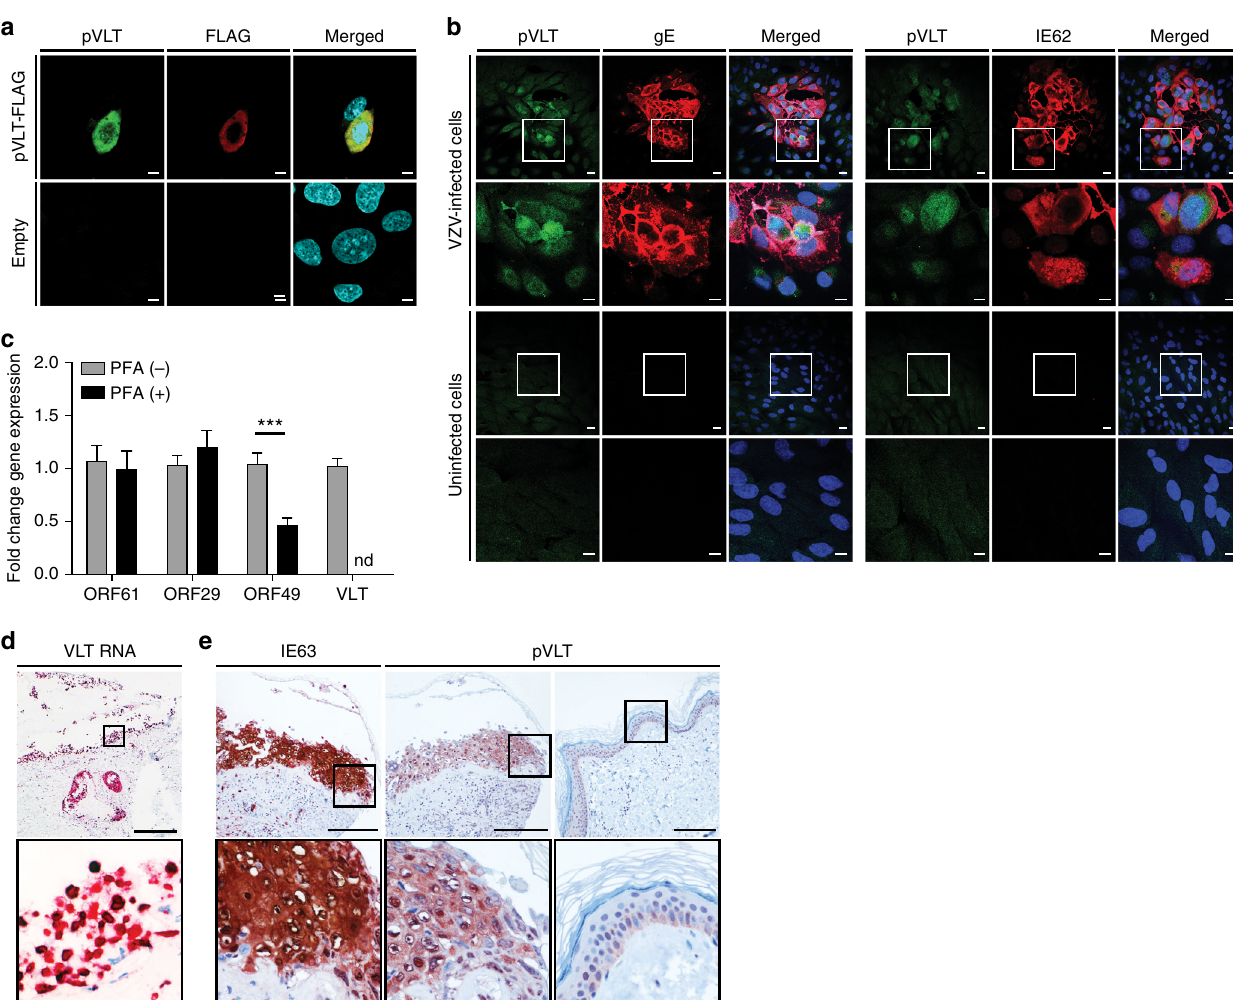
Fig. 5 Expression of VLT protein in vitro and in situ. a Representative confocal microscopic image of ARPE-19 cells at 48 h post-transfection with C-terminal FLAG-tagged VLT (pVLT-FLAG) expression plasmid or empty control plasmid (empty). pVLT-FLAG was detected with antibodies directed to FLAG (red) and VLT protein (pVLT; green). Magni fi cation: ×1000 and ×2 digital zoom. Bars = 5 µ m. b Representative confocal microscopic images of uninfected and VZV strain EMC1-infected ARPE-19 cells at 2 days post-infection, stained for both pVLT (green) and VZV glycoprotein E (gE; red) (left panel) or pVLT (green) combined with VZV ORF62 protein (IE62; red) (right panel). Magni fi cation: ×200, with area indicated by the white box shown at ×600. Bars = 20 µ m (×200) and 10 µ m (×600). In a , b , nuclei were stained with Hoechst 33342 (cyan) and images are representative of results from four independent experiments. c RT-qPCR quantitation of VZV ORF61, ORF29 and ORF49 transcript and VLT levels in VZV pOka-infected ARPE-19 cells cultured with (PFA + ) and without phosphonoformic acid (PFA − ) for 24 h. Data represent mean (±SEM) fold-change in gene expression, using the respective ‘ PFA − ' value as a calibrator, from four independent experiments. *** p < 0.001; Wilcoxon signed rank test. d Detection of VLT (red) in a human herpes zoster (HZ) skin lesion by in situ hybridization. Magni fi cation: ×100. Inset: ×400 and 2× digital zoom. Bar = 200 µ m. e Consecutive HZ skin sections stained immunohistochemically for ORF63 protein (IE63; brown) and pVLT (brown) (left and middle panels) and sections from unaffected control skin stained for pVLT (right panel). Magni fi cation: ×200. Inset: ×400. Bars = 100 µ m. Images in d , e are representative of fi ve HZ skin biopsies